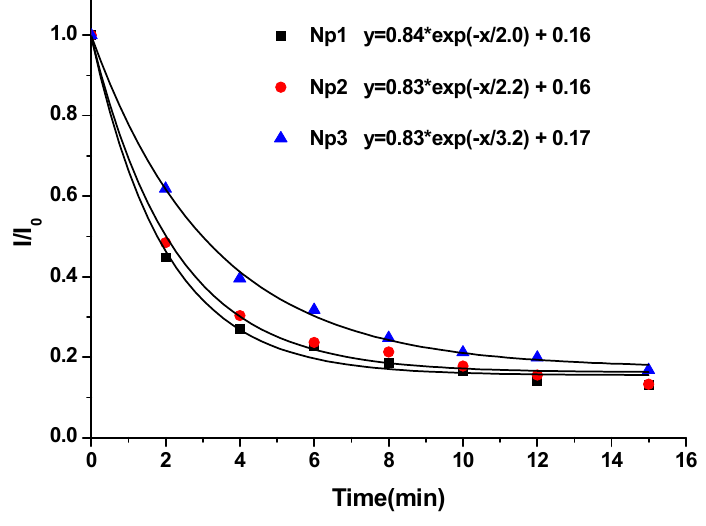
Figure 5. Plots of normalized fluorescence vs . irradiation time and curve fitting for Nile red loaded particle Np1–3 aqueous solutions exposed to UV light (365 nm, 11 mW/cm 2